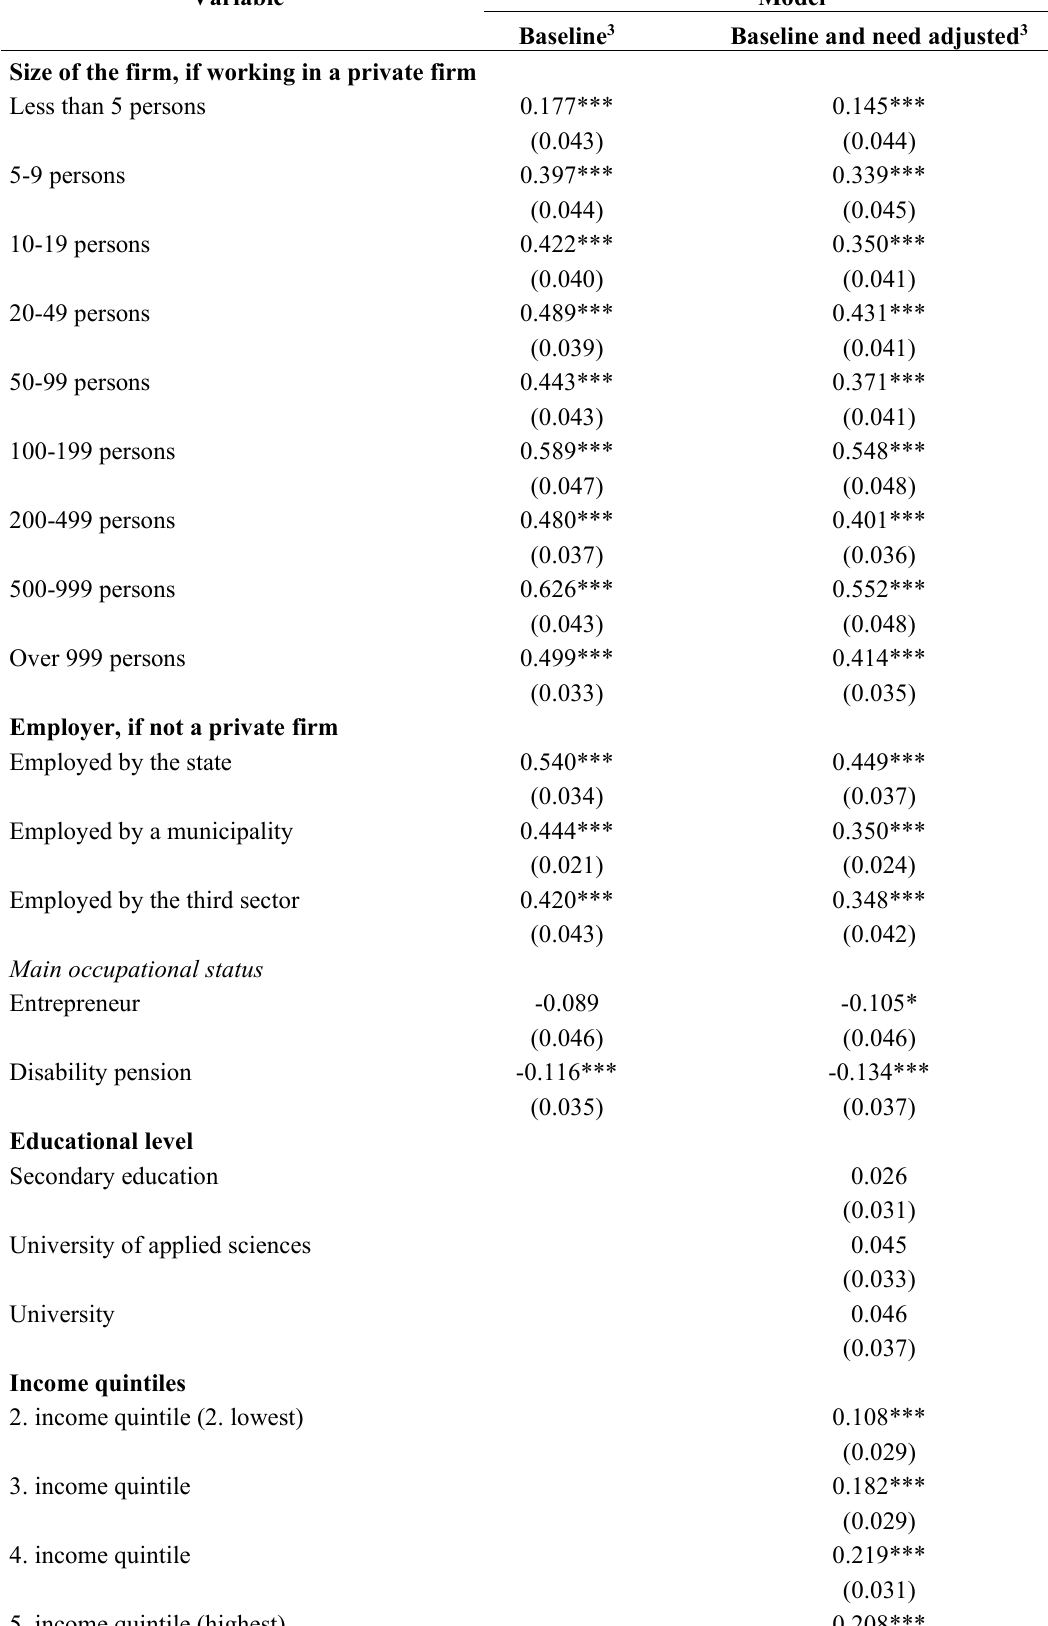
Table 2: Marginal effects of explanatory variables on the use of occupational healthcare Variable